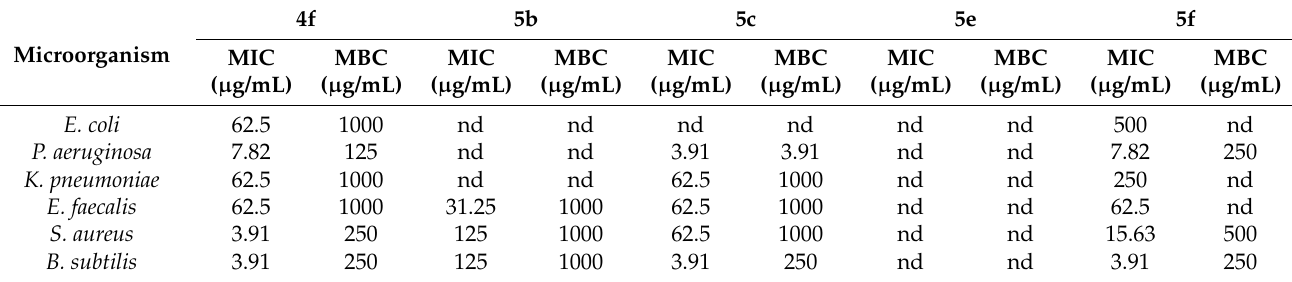
Table 7. MIC ( µ g/mL), MBC ( µ g/mL) of 4f , 5b , 5c , 5e, and 5f towards reference Gram-positive and Gram-negative bacterial strains upon blue light irradiation (see text for